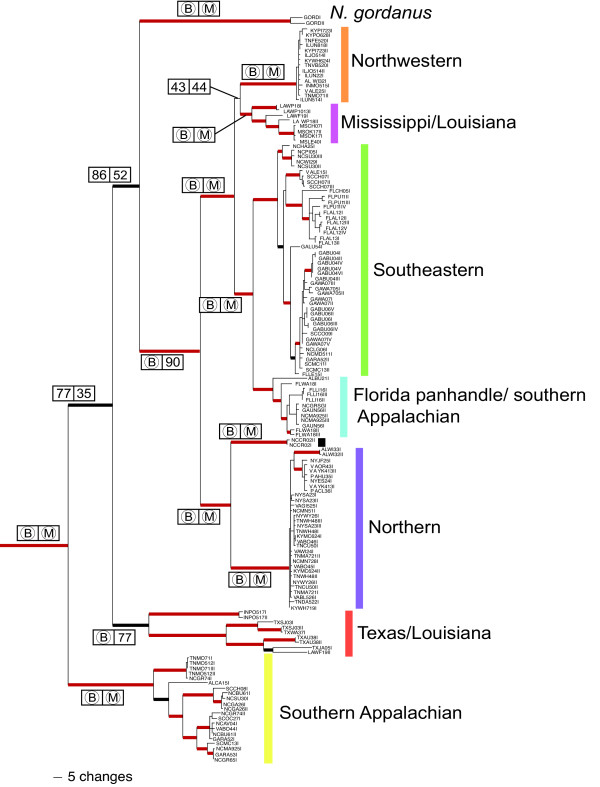
Inferred mtDNA haplotype phylogeny for Narceus using Bayesian inference. For major nodes, support values are represented in boxes. B and M represent posterior probabilities = 0.95 and maximum likelihood bootstrap values = 95%, respectively; PP and ML bootstrap values < 0.95 and 95% are represented by numbers in respective boxes. Thick red and thick black branches indicate PP = 1.00 and 0.70 – 0.95, respectively.